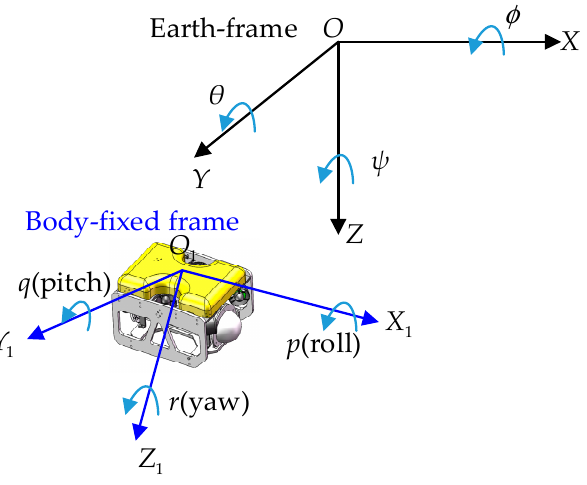
Figure 3. Two coordinate systems for the AUV.